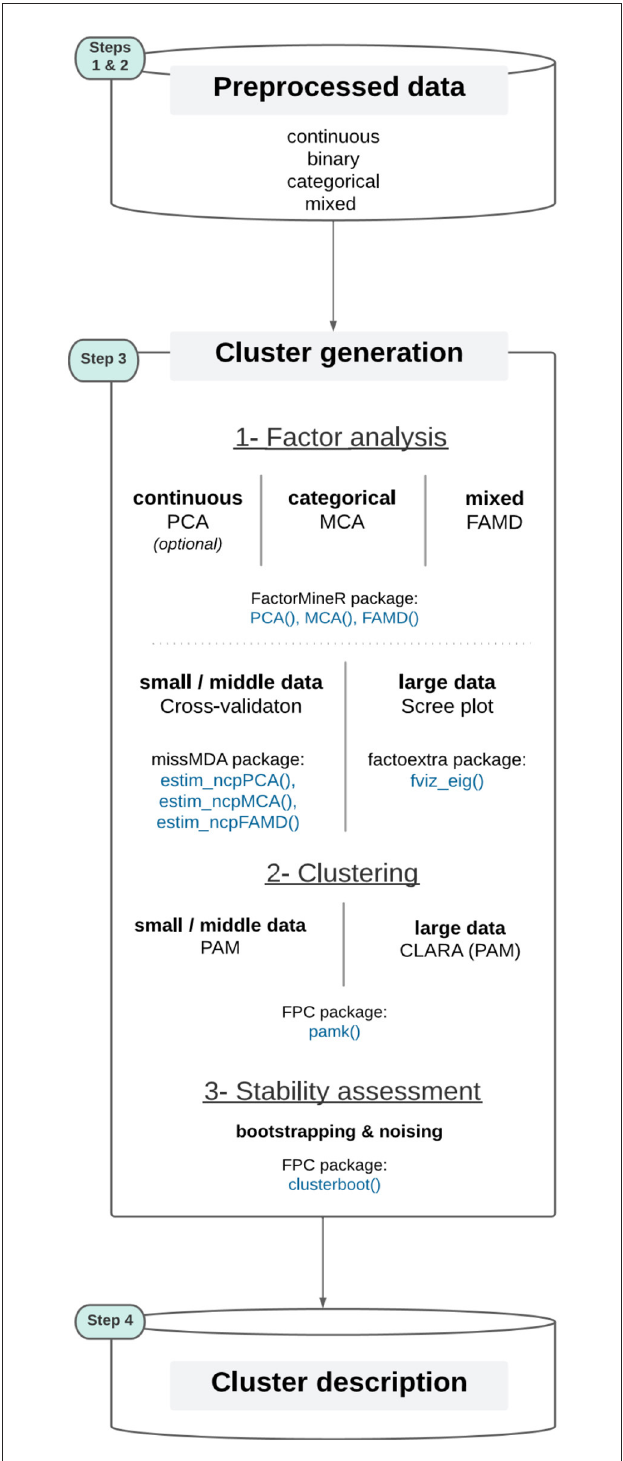
FIGURE3 The Qluster workflow (the colored step pads correspond to those detailed in Figure